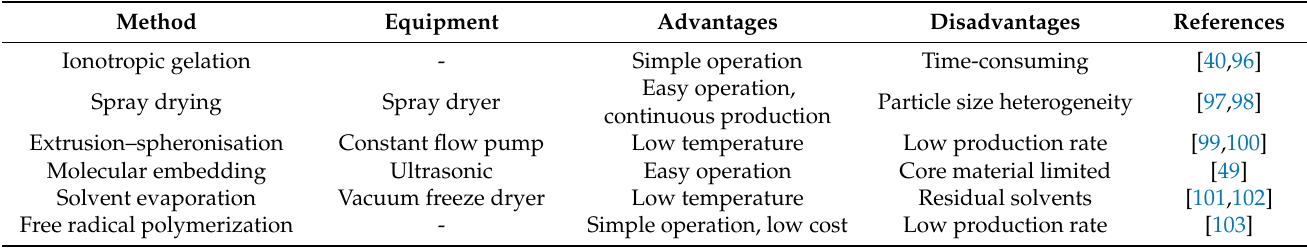
Table 2. The traditional preparation methods for peptides